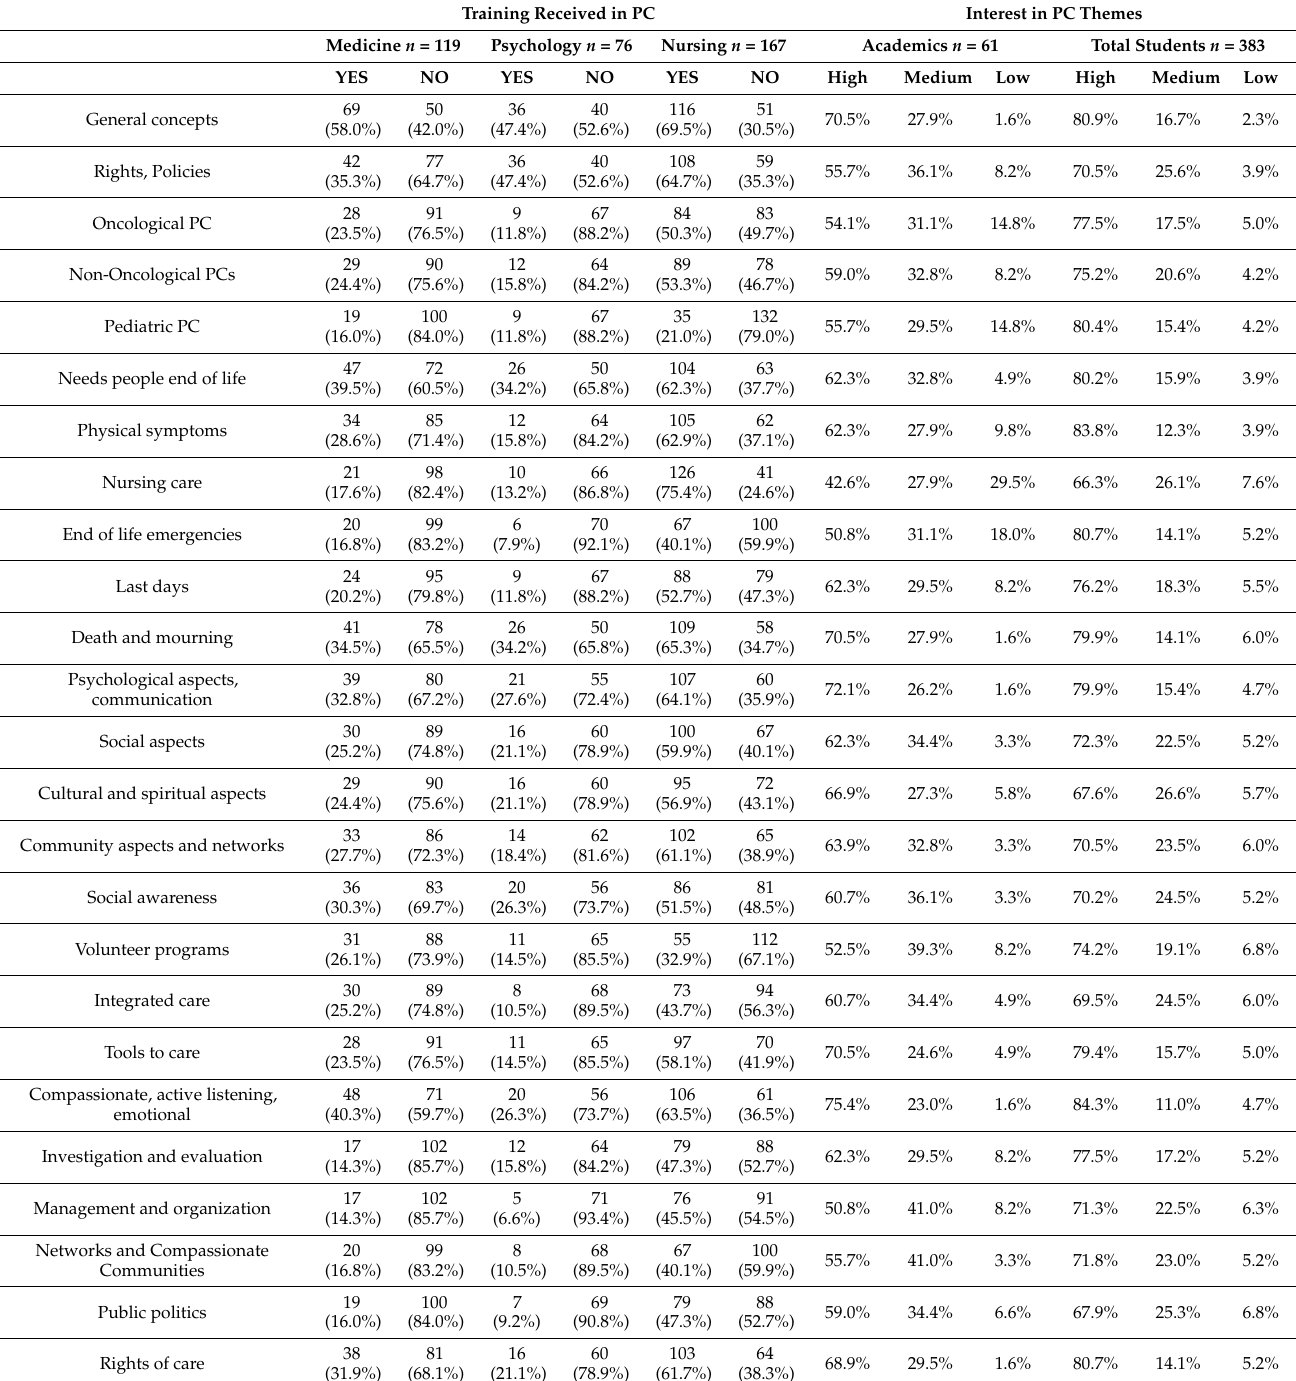
Table 3. Topics received and interest in palliative